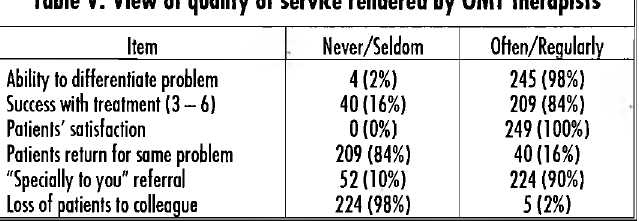
Table V. View of quality of service rendered by OMT therapists